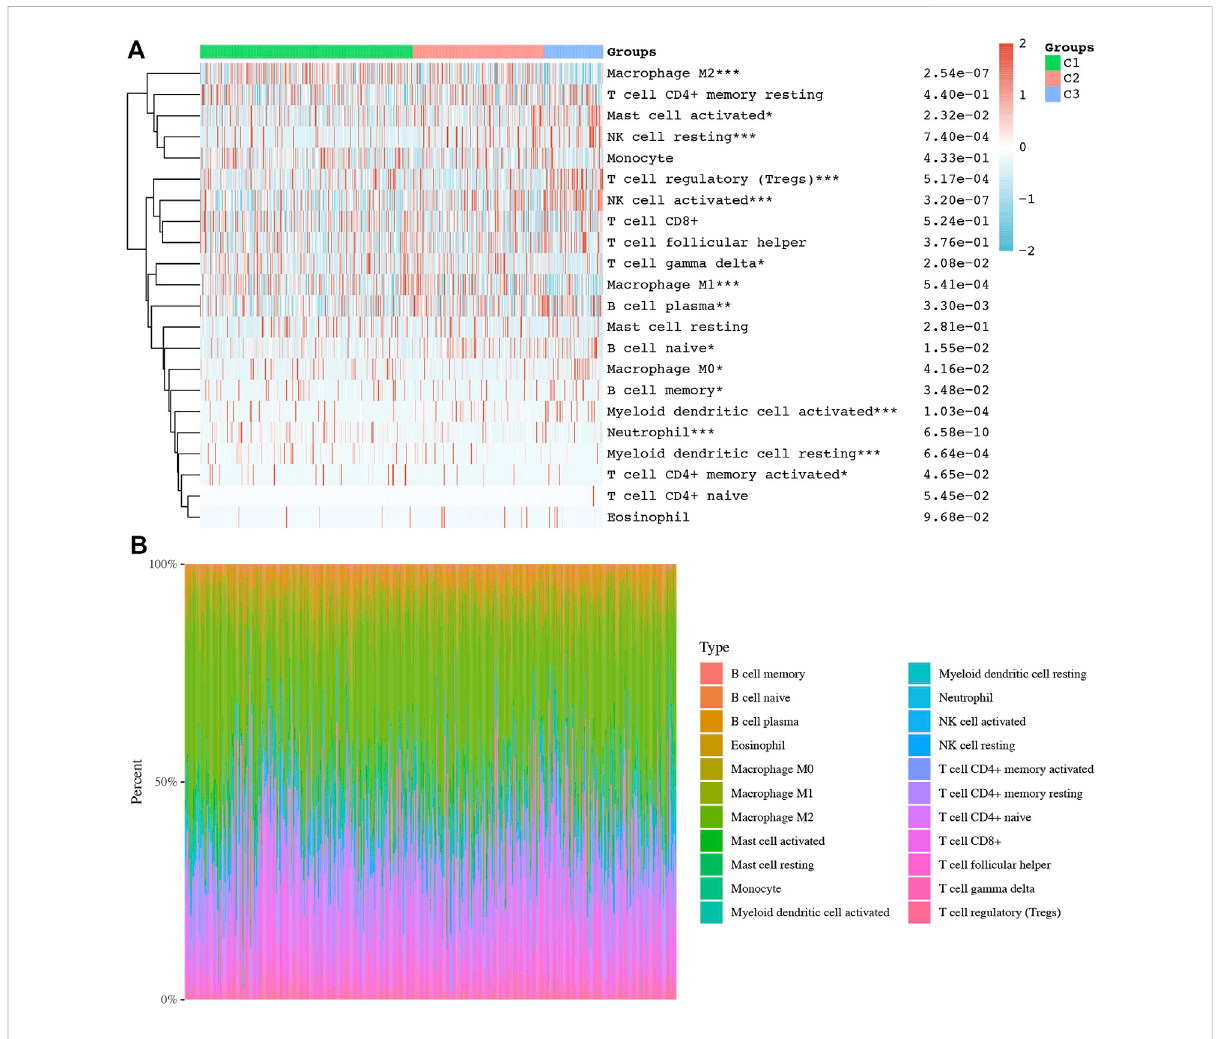
FIGURE 4 Difference of immune cell in fi ltration in three subtypes of ccRCC. (A) Abundance of different immune cells in three clusters of ccRCC. (B) Distribution of different immune cells in each ccRCC case. * p < 0.05; ** p < 0.01; *** p < 0.001; ccRCC, clear cell renal cell